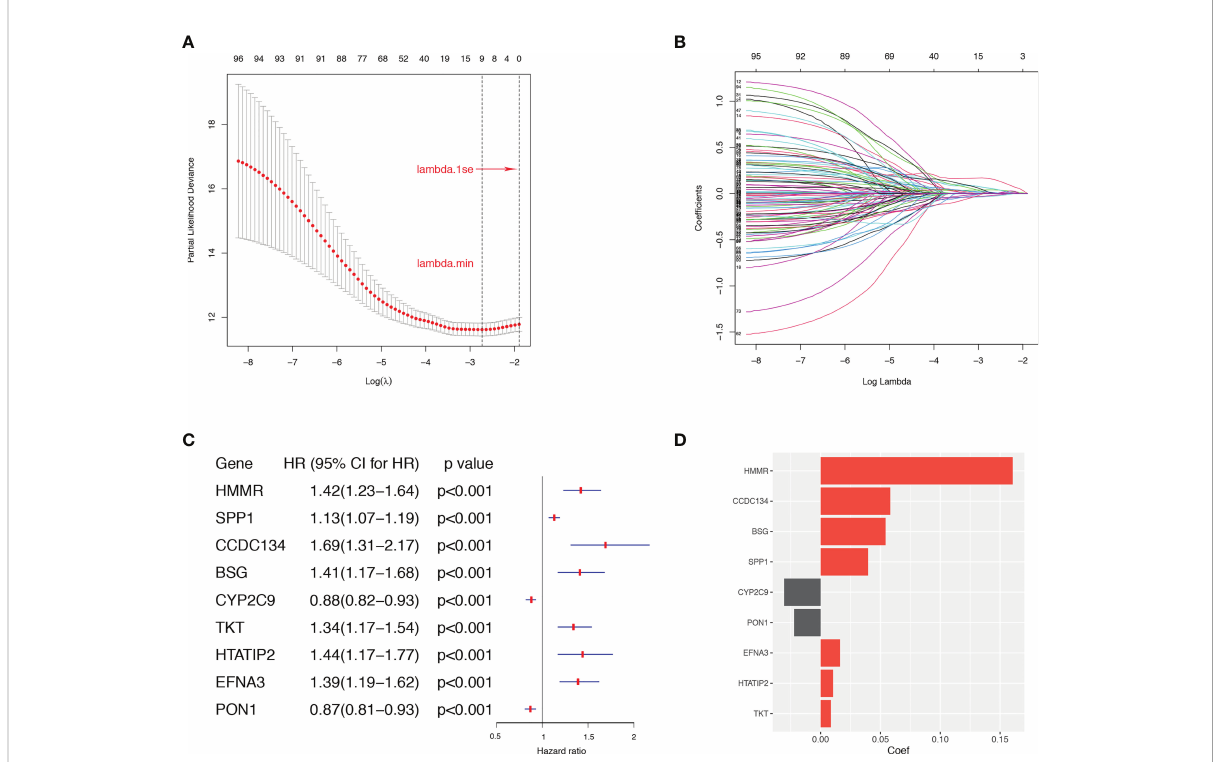
FIGURE 4 The LASSO regression analysis in the TCGA dataset. (A) Selection of the optimal parameter (lambda.min) in the LASSO model. (B) LASSO coef fi cient pro fi les of ARGs in TCGA dataset. (C) The retained 9 candidate genes. (D) LASSO coef fi cient of the 9 candidate genes for ARGs Scoring model